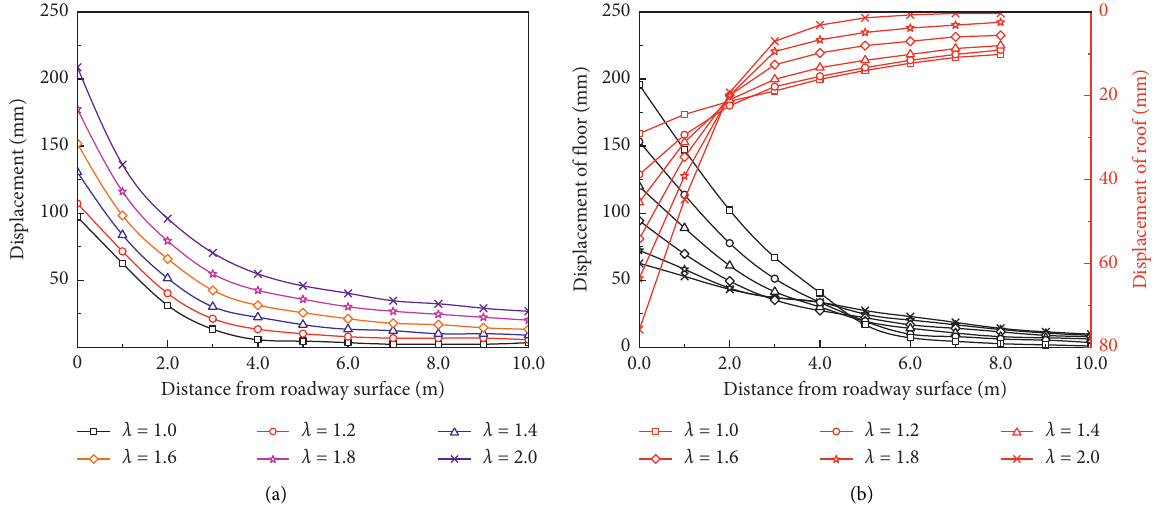
Figure 13: The displacement distribution of the roadway. (a) Two sides; (b) roof and floor.